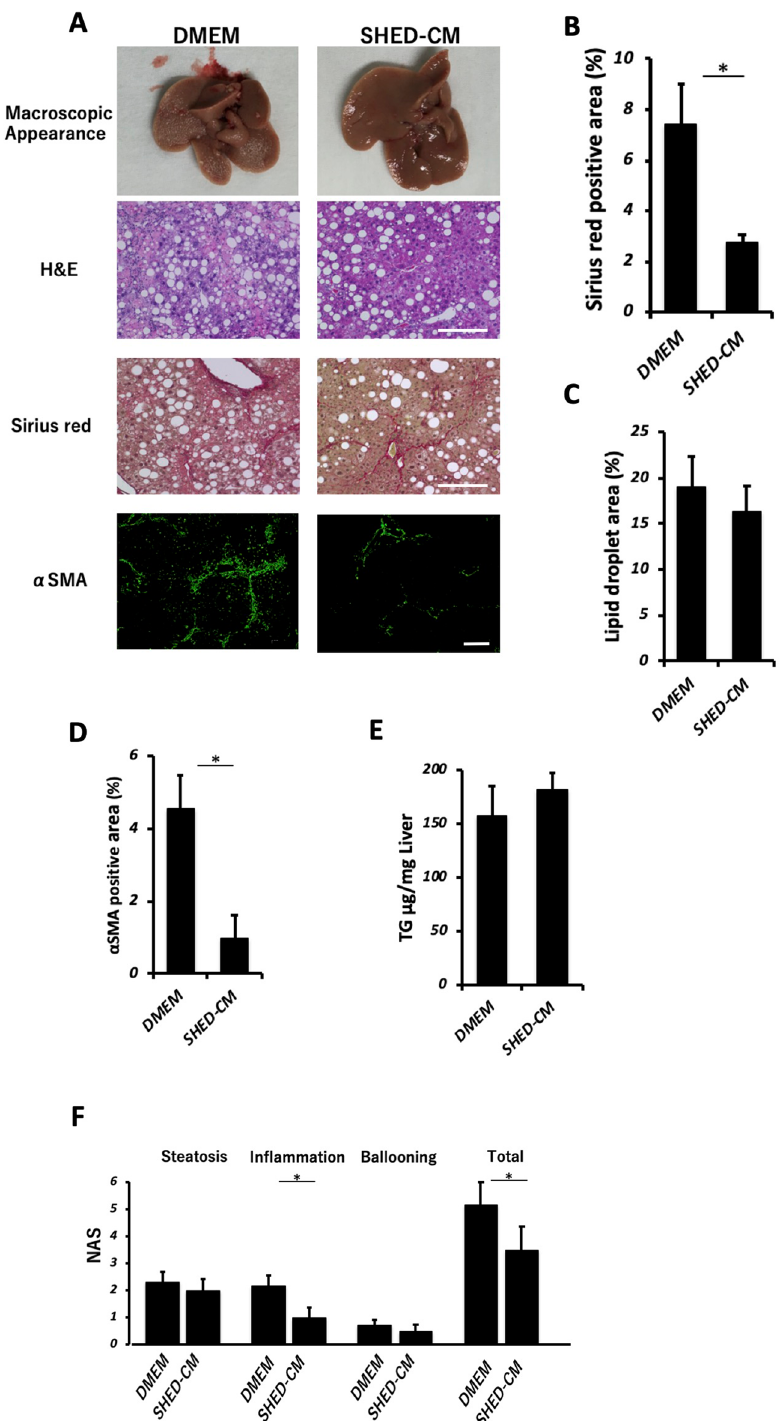
Figure 2. Therapeutic effect of SHED-CM in a murine NASH model. ( A ) Representative images of macroscopic appearance, H&E, Sirius red, and α-SMA immunofluorescent stained livers. Scale bar = 200 μm. ( B ) Quantification of Sirius red-stained areas. ( C ) Quantification of lipid droplet areas according to H&E staining. ( D ) Quantification of α-SMA positive areas according to immunofluorescent staining. ( E ) TG quantification in livers. ( F ) NAS is the sum of the lobular inflammation, ballooning, and steatosis scores according to H&E score. Data represent mean ± SEM. * P < .05. n = 6, DMEM group; n = 8 SHED-CM group. Abbreviations: H&E, hematoxylin and eosin; α-SMA, α-smooth muscle actin; DMEM, Dulbecco’s modified Eagle’s medium; SHED-CM, serum-free conditioned medium from stem cells derived from human exfoliated deciduous teeth; TG, triglyceride; NAS, non-alcoholic fatty liver disease activity